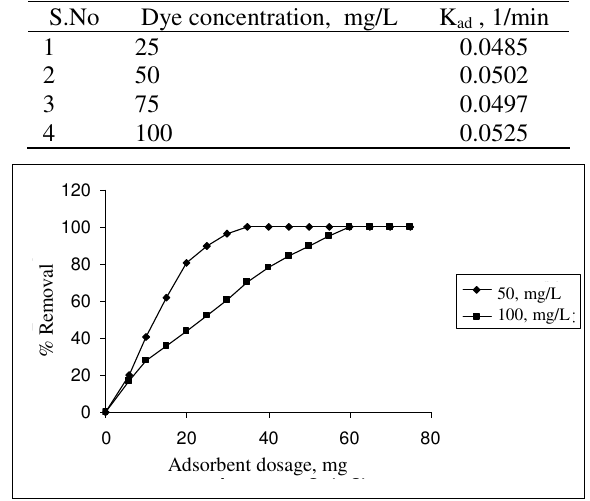
Figure 4. Effect of adsorbent dosage on crystal violet